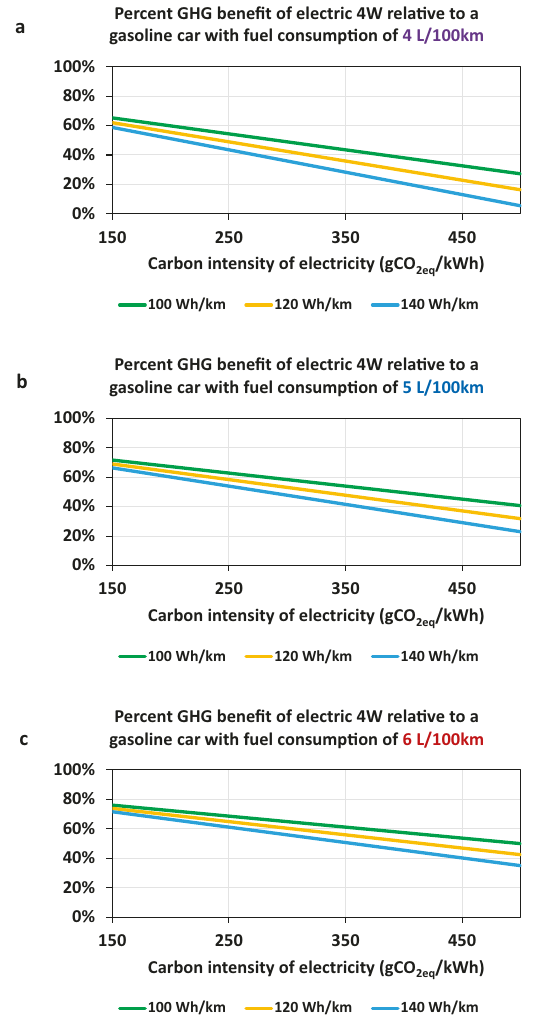
Fig. 4 Future GHG emissions reduction potential of 4 W BEVs with deeper decarbonisation of the electricity grid. The life cycle GHG emissions reduction is calculated for a 4 W BEV with different energy consumptions (100, 120, and 140 Wh/km), equipped with a 30 kWh battery, compared to traditional gasoline vehicles with fuel